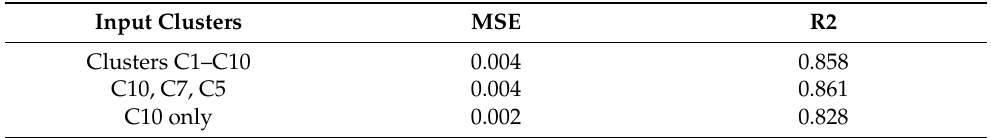
Table 1. Prediction error and effectiveness for various input scenarios. Three models were run: one on the complete dataset (including outliers), one for clusters C10, C7 and C5, and one for C10 only. MSE = Mean Square Error; R2 = R-squared, or the coefficient of